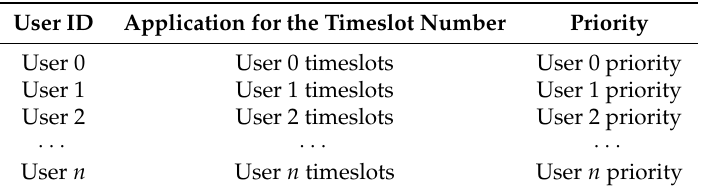
Table 1. Reservation